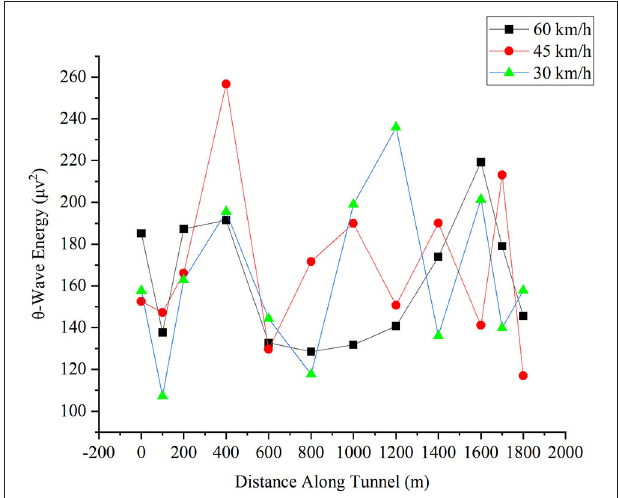
FIGURE 8 | Change in θ -wave energy in the frontal lobe for different driving speeds.